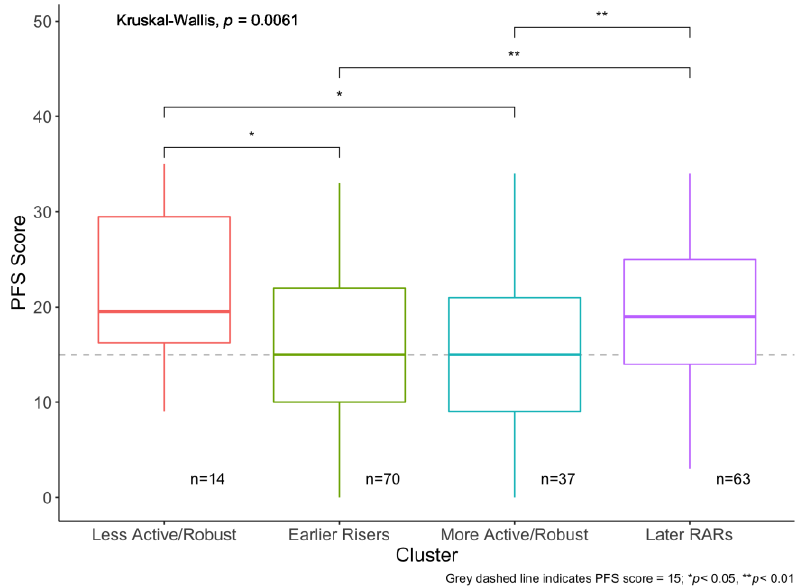
Figure 4. Rest–activity rhythm (RAR) profiles defined by k-means cluster analysis and their asso- ciation with the PFS score. Differences in the Pittsburgh Fatigability Scale (PFS) Physical scores by cluster assignment. Overall differences tested with the Kruskal–Wallis test, and pairwise differences tested with two-sample Wilcoxon Rank Sum.